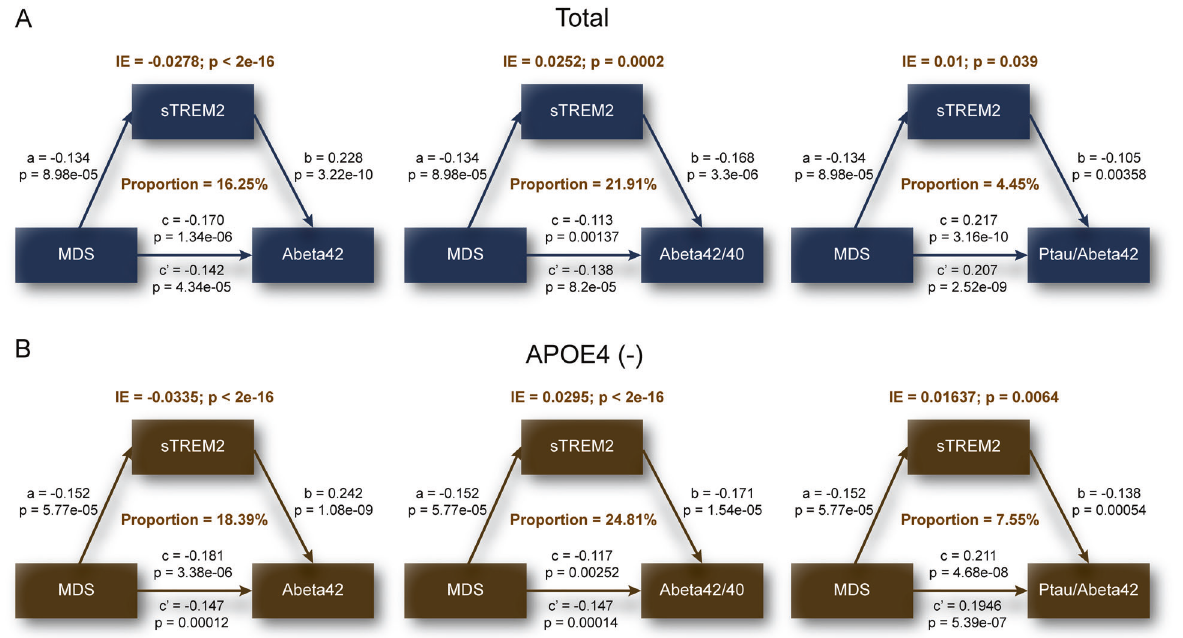
Fig. 3 CSF sTREM2 mediated association between MDS and amyloid pathology. Models of mediation for MDS, CSF sTREM2, and CSF amyloid markers (ie. A β 42, A β 42/40, Ptau/A β 42), with MDS as independent variable and CSF sTREM2 as mediator and CSF amyloid markers as dependent variable. Mediation effects of CSF sTREM2 are shown in total ( A ) and APOE ε 4 non-carriers ( B ). CSF cerebrospinal fl uid; sTREM2 soluble of trigging receptor expressed on myeloid cells 2; MDS minimal depressive symptom; APOE apolipoprotein E. A β amyloid- β ; P-tau phosphorylated tau; IE indirect